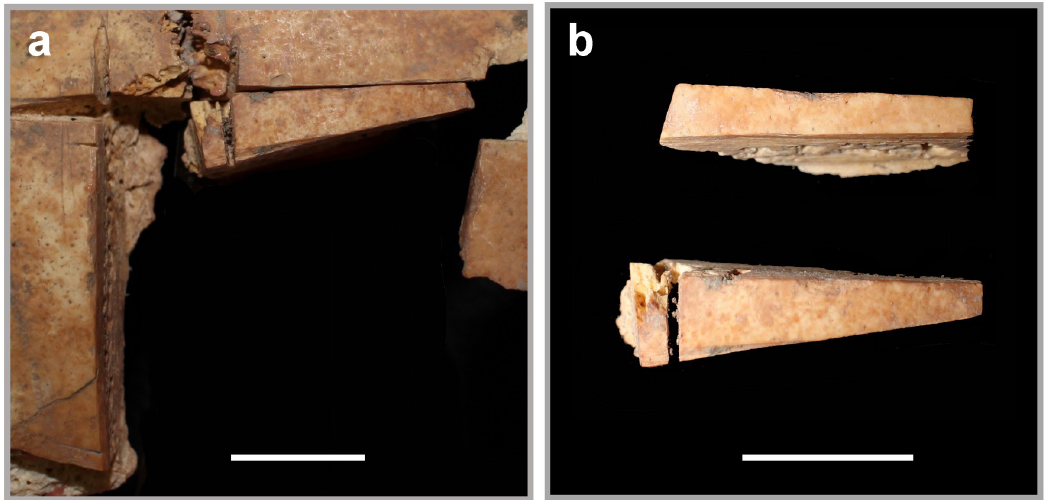
Fig 7. Excised cranial pieces. Left: Trephination with refit excised cranial piece. Right: Both extant pieces found during analysis. All scale bars are 1 cm.